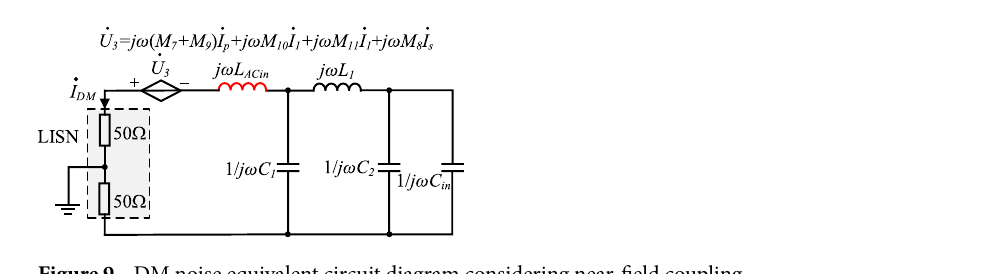
Figure 9. DM noise equivalent circuit diagram considering near-field